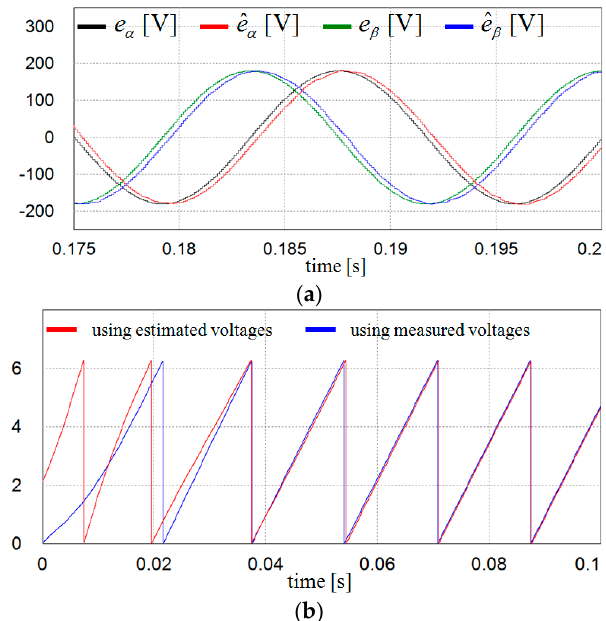
Figure 6. Estimation of grid voltages and phase angle using DOB under the ideal grid condition. ( a ) Measured and estimated stationary q -axis and d -axis grid voltages; and ( b ) phase-locked loop (PLL) results using the measured voltages and estimated voltages at start-up.